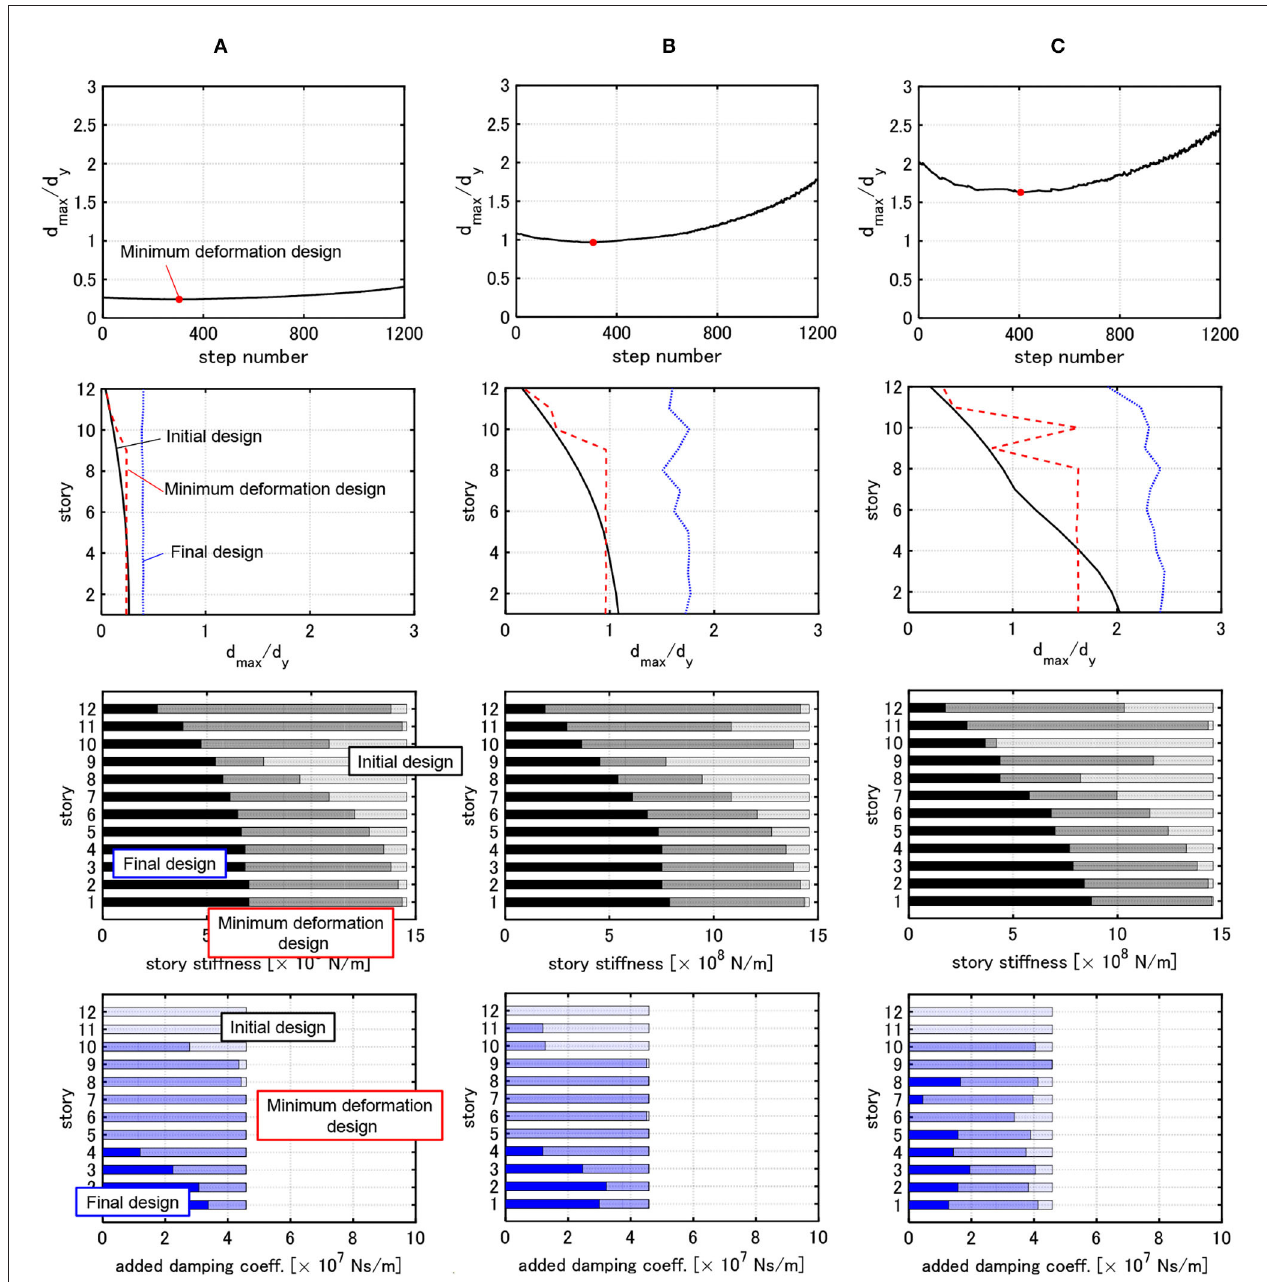
FIGURE 7 | Change of maximum deformation, distribution of d max, i / d y , distribution of story stiffness and distribution of damper damping coefficient of 3 cases with W cF = 10 × 10 7 [ Ns / m ]. (A) Model designed under critical double impulse with V = 0.25[ m / s ]. (B) Model designed under critical double impulse with V = 1.0[ m / s ]. (C) Model designed under critical double impulse with V = 1.5[ m / s ].